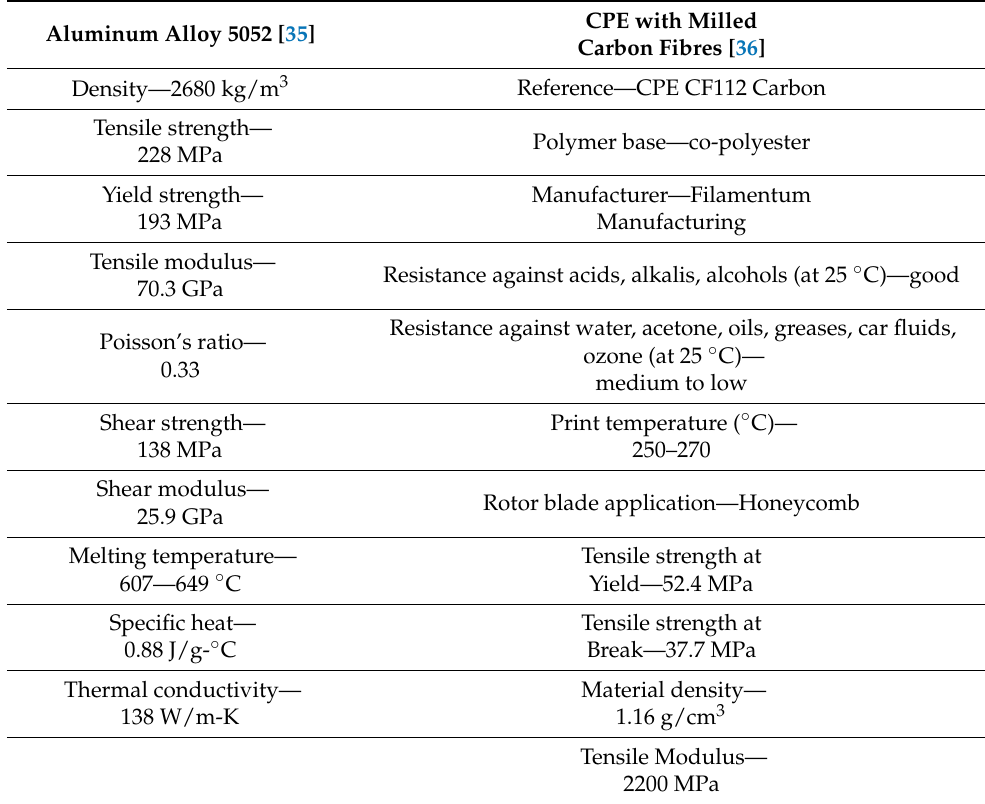
Table 1. Main mechanical properties of the honeycomb